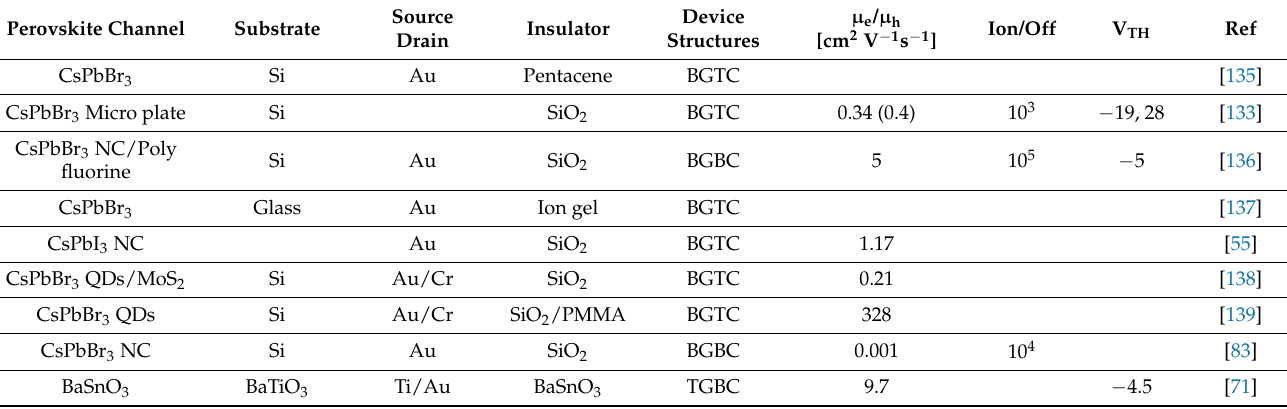
Table 3. The all-inorganic perovskite structured material channel based thin-film field-effect transistor works in the literature after